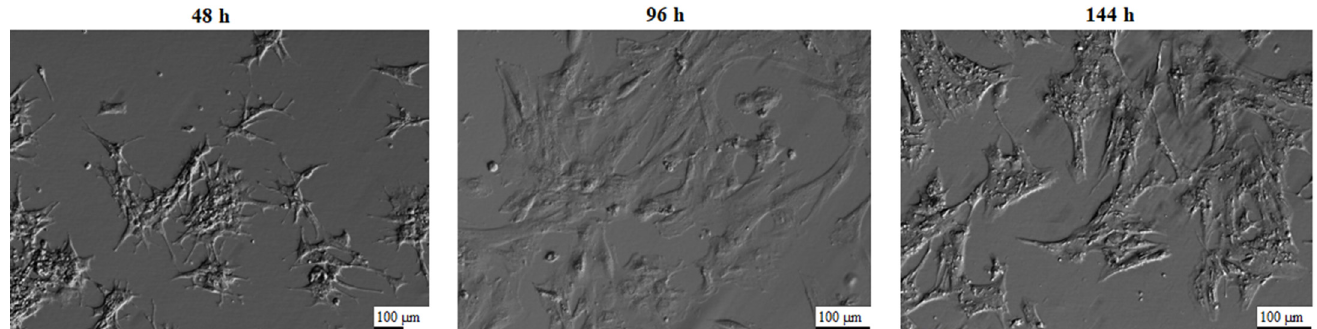
Figure 1. Porcine granulosa cells cultures used for the experiment, presenting changes in their morphology, following 48 h, 96 h, and 144 h of in vitro culture (magnification ×100 (48 h), magnification ×200 (96 h, 144 h)).